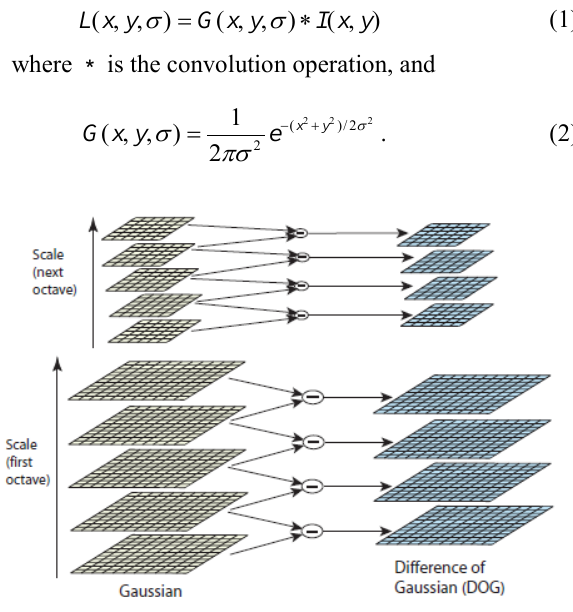
Fig. 1. Difference-of-Gaussian